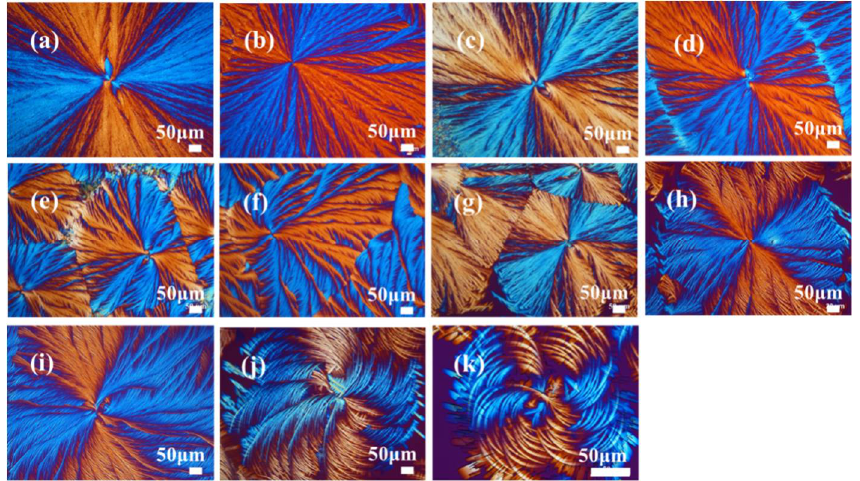
Figure 3. POM graphs of (S)-MA/PVPh (50/50) blend at different T c : ( a ) 30, ( b ) 35, ( c ) 36, ( d ) 40, ( e ) 45, ( f ) 48, ( g ) 50, ( h ) 55, ( i ) 60, ( j ) 63, and ( k ) 65 °C.